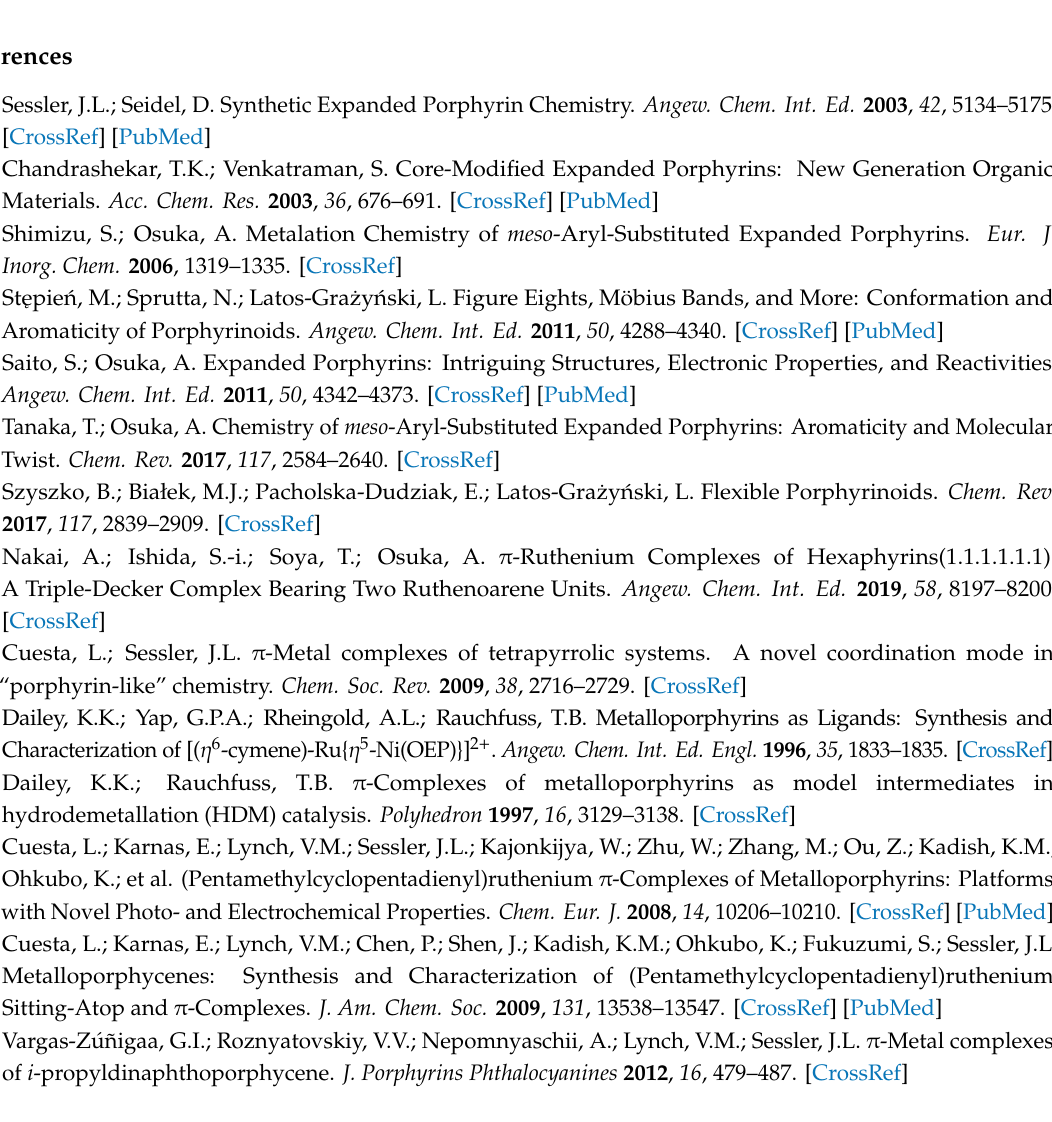
Figure S3: Observed and simulated HR-APCI-TOF-MS, Figures S4 to S6: UV / Vis absorption spectra, Figure S7: Cyclic voltammograms, Figures S8 and S9: X-Ray structures, Figures S10 and S11: Kohn–Sham orbital diagrams, Figures S12 to S14: Calculated absorption spectra, Figures S15 and S16. ACID isosurfaces, Figures S17 and S18: NICS(0) values, Figures S19 to S21: Three-dimensional molecular electrostatic potential, Tables S1 and S2: Bond lengths (X-ray and DFT calculation) and bond order (DFT), Tables S3 and S4: Harmonic oscillator stabilization energies and estimated weights, Schemes S1 and S2: Plausible resonance contributors. References [29–31] are cited in the supplementary